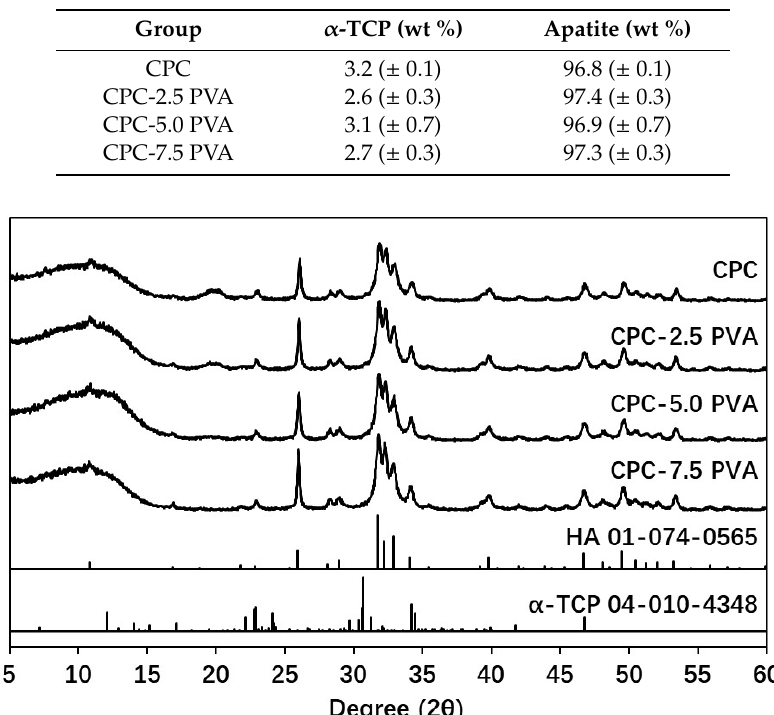
Figure 6. Representative XRD patterns of samples (one of three measurements is shown per group) and the reference Powder Diffraction Files (PDFs).